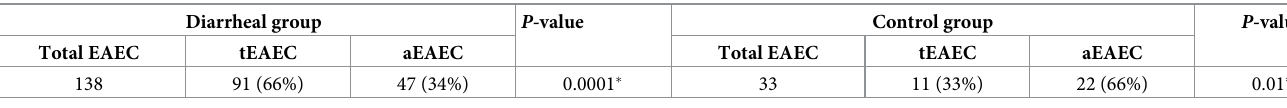
Table 7. Distribution of tEAEC and aEAEC isolates in diarrheal and control group. Diarrheal